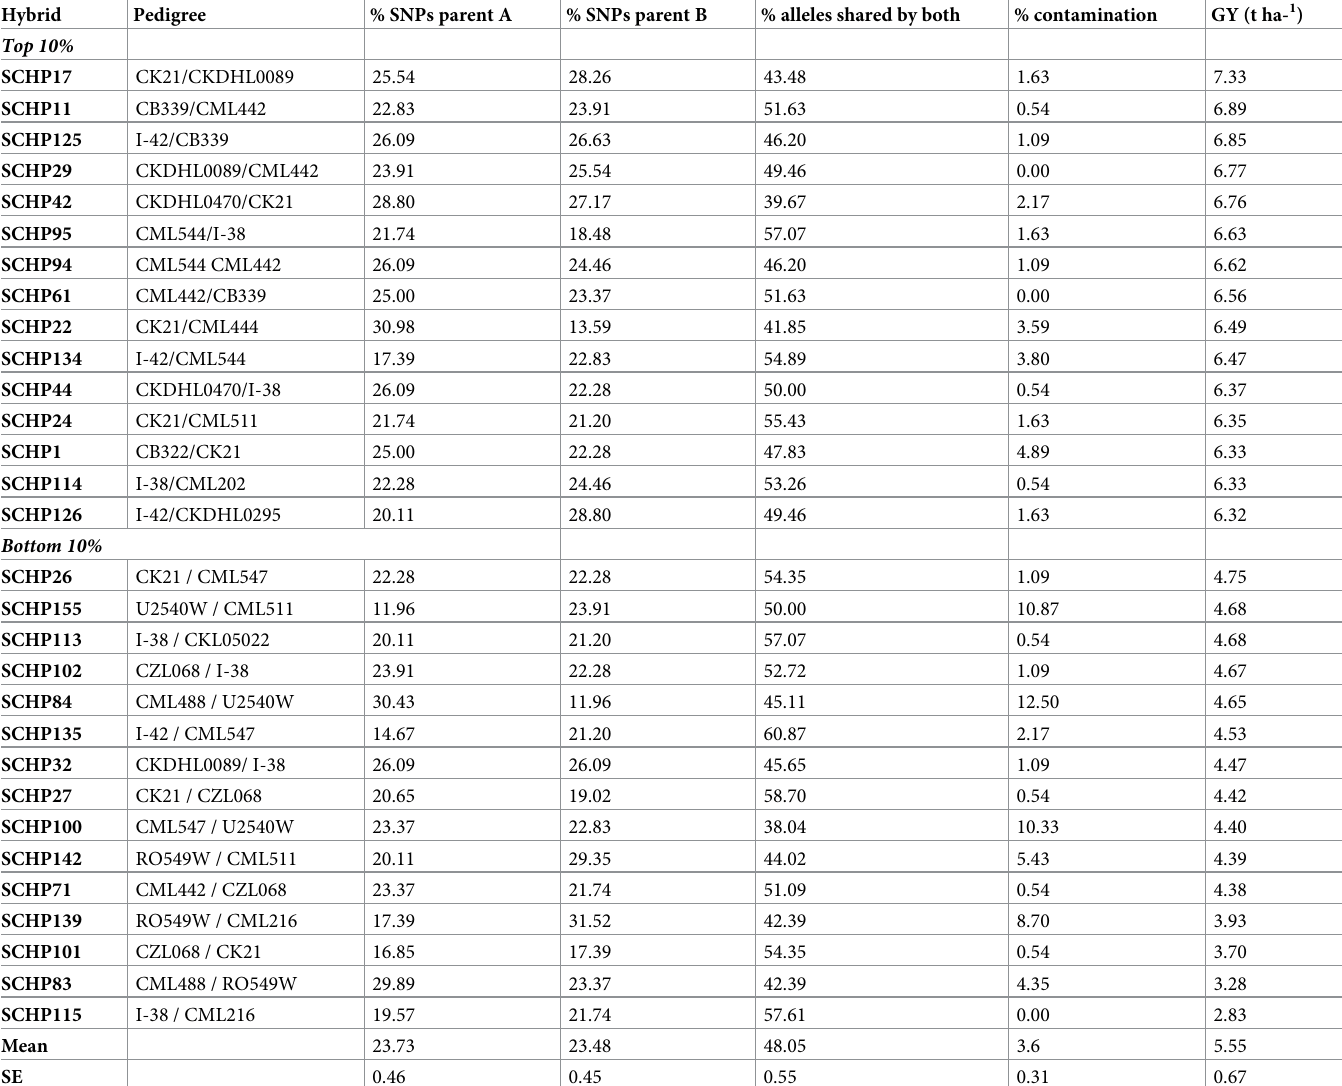
Table 3. Parent-offspring test for top and bottom 10% performing hybrids based on grain yield. Hybrid